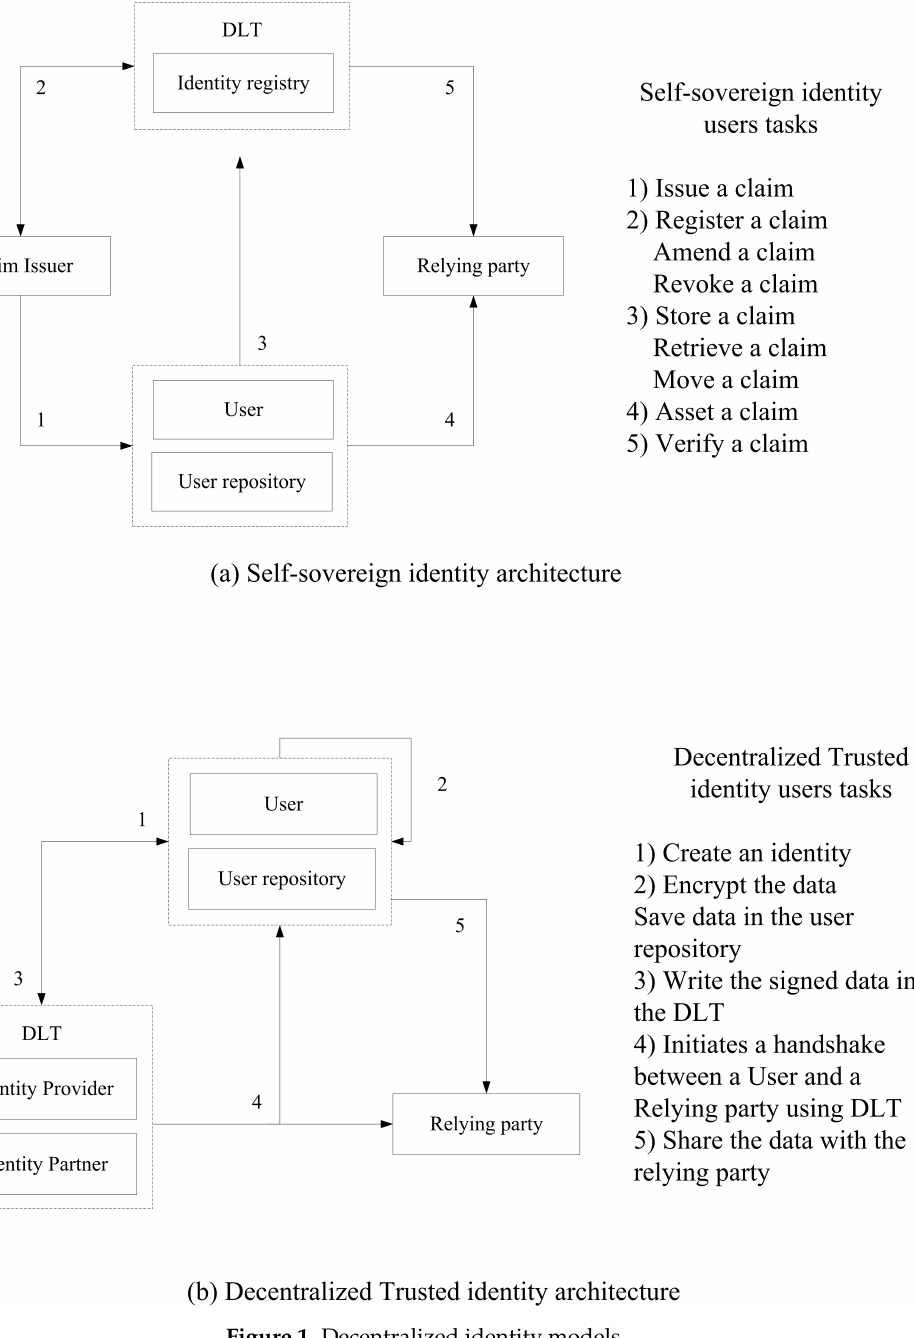
Figure 1. Decentralized identity